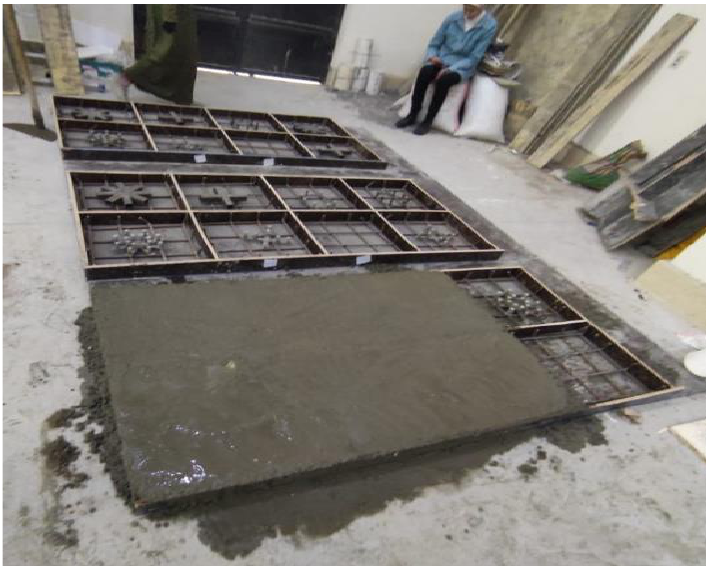
Table 2. Weight in kilograms of components for preparing a cubic meter of each type of concrete.